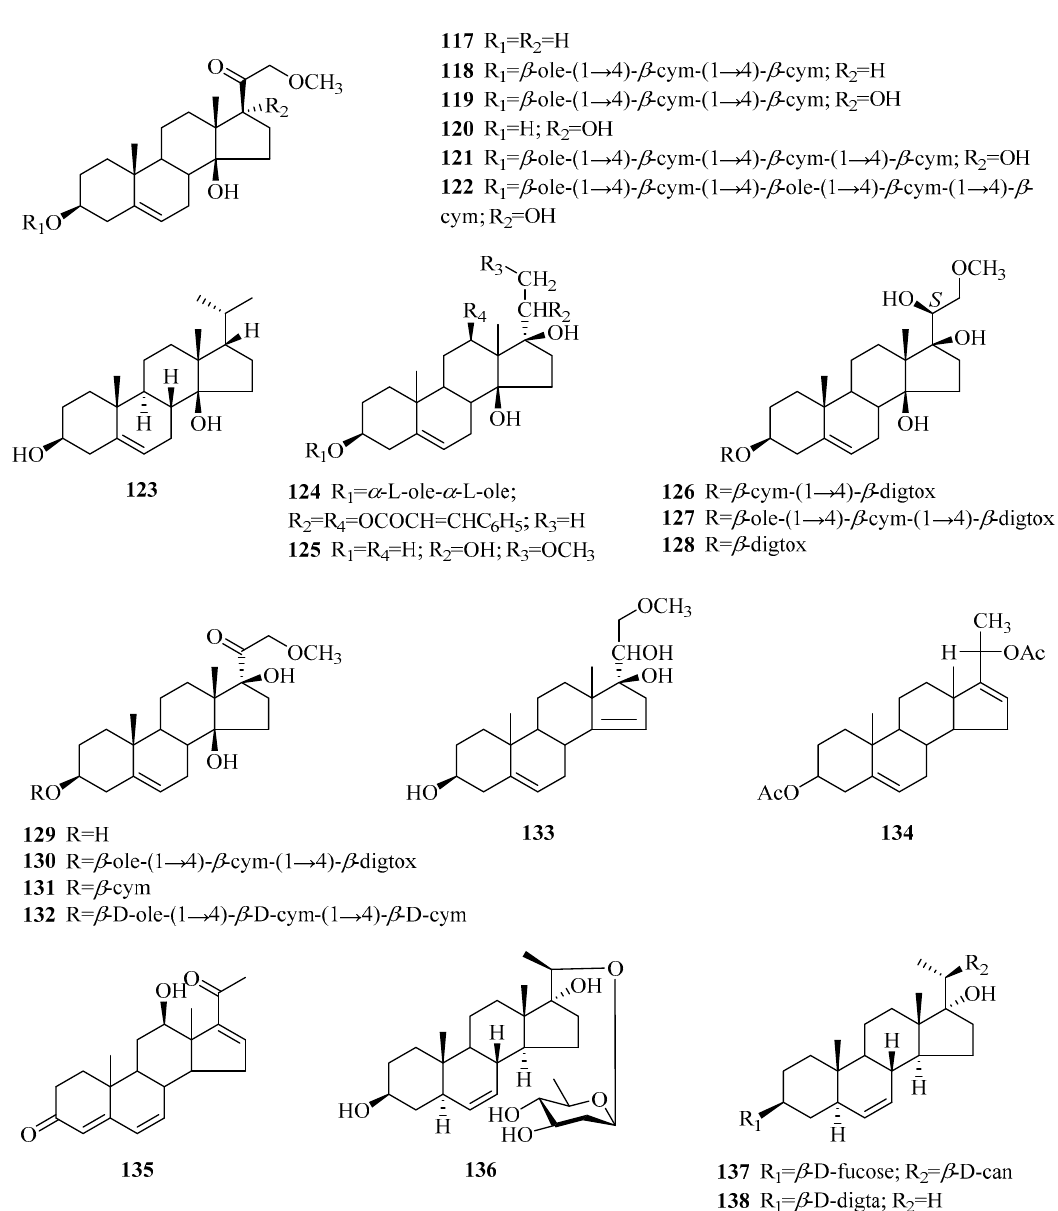
Figure 3. C 21 pregnane-type steroids from the genus Periploca .